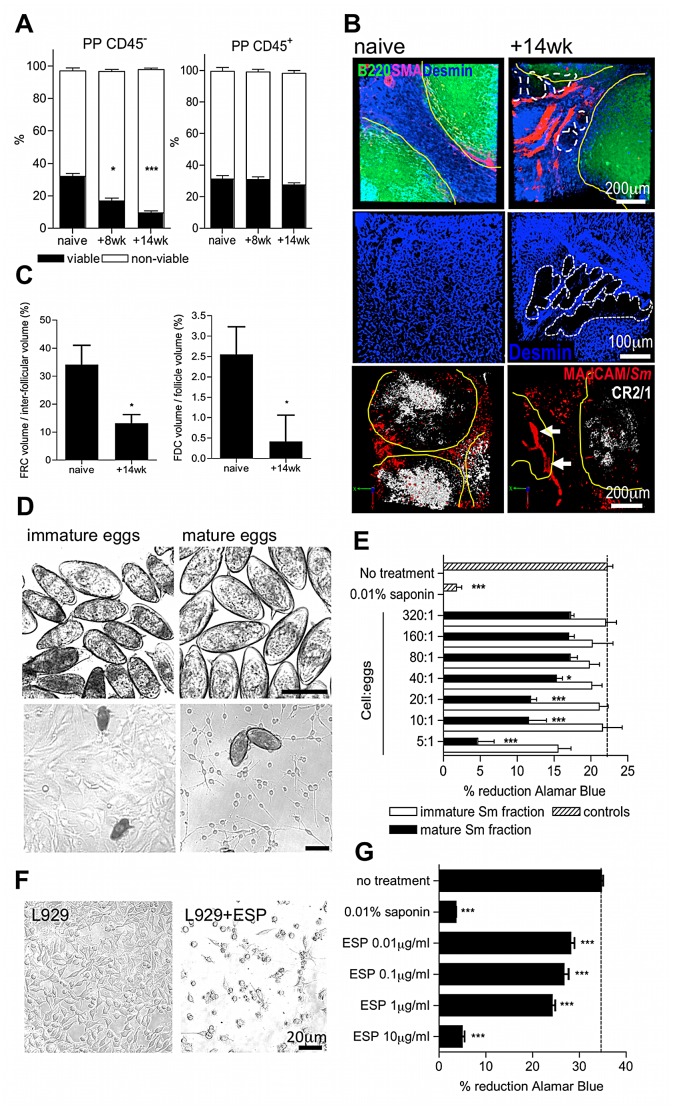
Egg deposition and their secretions elicit damage to PP stroma.(A) Viable (annexinV−/propidium iodide−) CD45− but not CD45+ cells decline in PP cell suspensions after infection; *P<0.05, ***P<0.001, cf. naïve, 1-way ANOVA with Tukey's post-hoc. (B) Upper panels: 3D confocal imaging of PP showing B220+ cell follicles (green, yellow outline), desmin+/smooth muscle actin− fibroblast-like reticular cells (FRC, blue) and desmin+/smooth muscle actin+ blood vessel basement membranes (pink). Dashed lines demarcate void space in FRC tissue. Middle panels: high magnification of desmin+ FRC within PP interfollicular region. Dashed lines demarcate void space in FRC tissue. Lower panels: 3D confocal imaging of PP showing B220+ cell follicles (yellow outline), CR2/1hi follicular dendritic cells (FDC, white) and MAdCAM+ high endothelial venules (red). Intravascular S. mansoni eggs (red autofluoresence) are indicated by arrows. (C) FRC+ and FDC+ tissues as a proportion of inter-follicular volume, or follicular volume: min 3 PP/mouse, *P<0.05, cf. naïve, unpaired T-test. Representative of 2–3 independent experiments, n = 4–5. (D) Phase-contrast images of immature or mature eggs co-cultured with OP9 bone marrow fibroblast stroma (bars = 100 µm). (E) Metabolic activity of fibroblasts 72 h after co-culture as determined by Alamar Blue. (F) Phase contrast images of L929 fibroblasts 72 h post culture in the presence, or absence, of 10 µg/ml secretions from mature eggs (ESP). (G) Metabolic activity determined by Alamar Blue reduction of L929 fibroblasts co-cultured for 72 hr with different concentrations of ESP; untreated control = dashed line. *P<0.05, ***P<0.001, cf. naïve or untreated control, 1-way ANOVA with Tukey's post-hoc. Data are means (+SEM), n = 3–5, representative of 3 independent experiments.